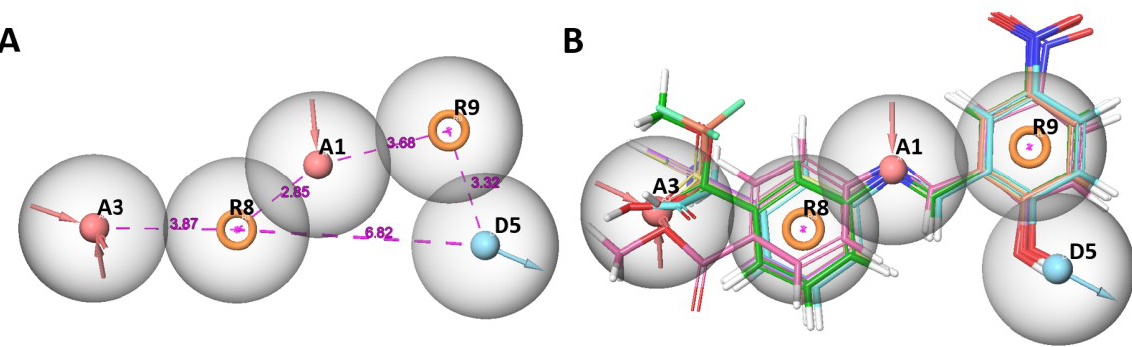
Figure 3. ( A ) Pharmacophore hypothesis of AADRR_1, and distances between pharmacophores; ( B ) alignment of AADRR_1 with all the active and inactive compounds.